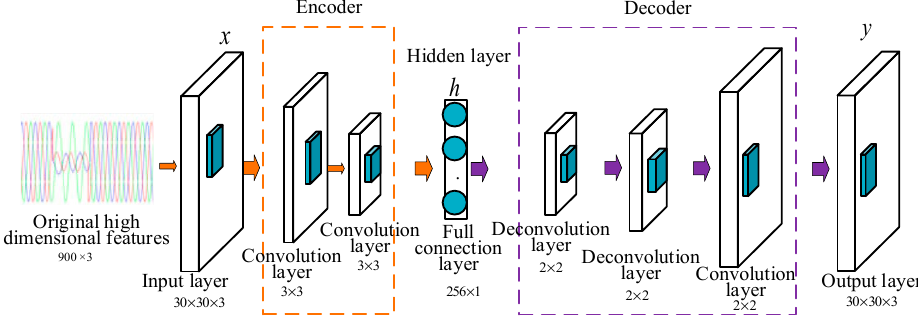
Figure 3. AE network structure diagram.